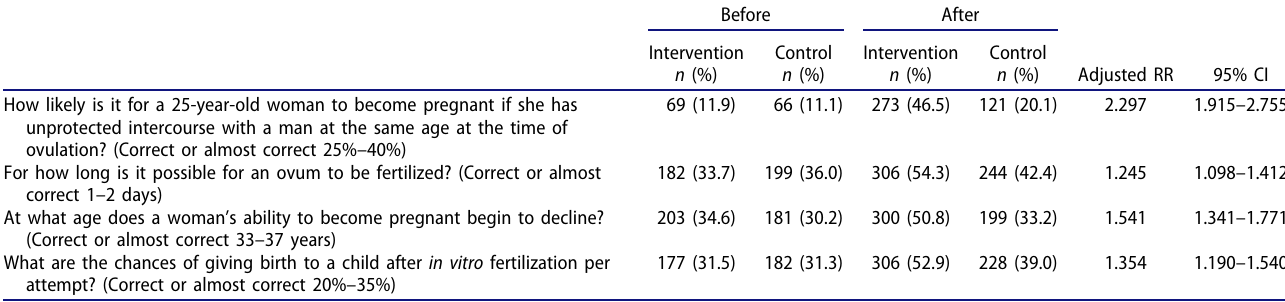
Table 3. Percentage of women in the intervention group and the control group who responded correctly or almost correctly to questions about fertility.